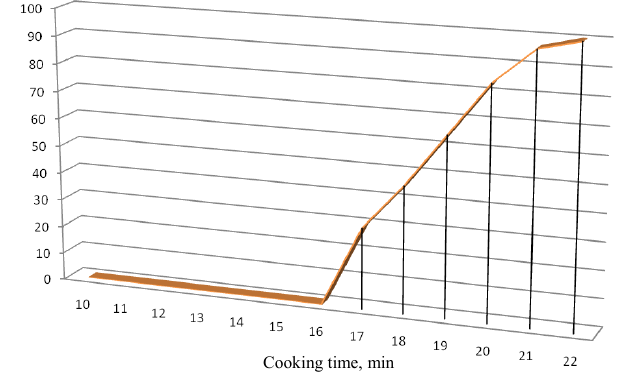
Figure 2. Gelatinization profile of HD5 rice samples.